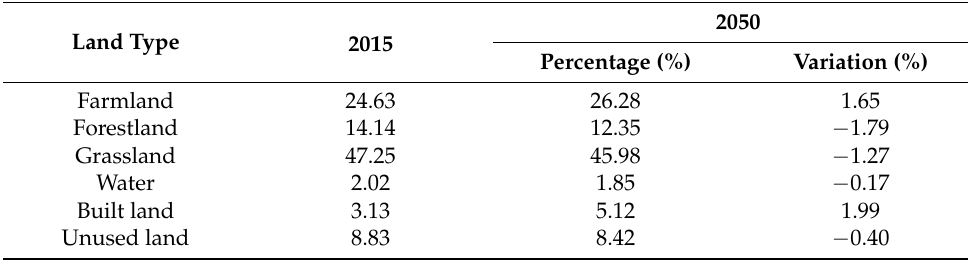
Table 6. Comparison of land types percentage in the Yellow River Basin in 2015 and in 2050 under status quo continuation scenario.